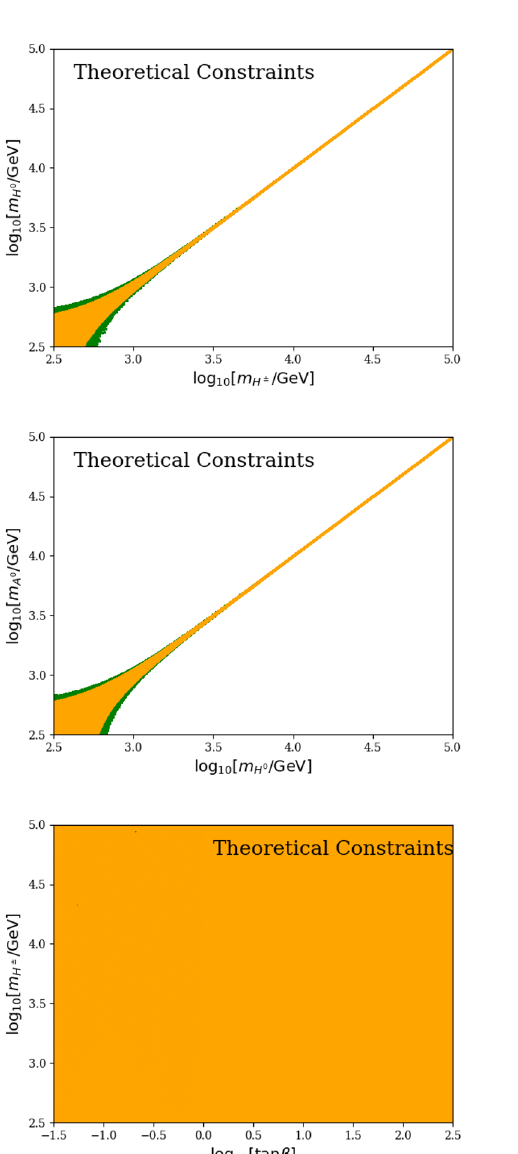
Figure 1. Bounds on the heavy Higgs masses m from the theory constraints (perturbativity, vacuum stability and unitarity conditions). For the plots 10 8 points were generated and only values of | δ | < 0 . 5 were considered. The starting values | λ i | < 4 π are given in green, while | λ i | < 4 is shown in